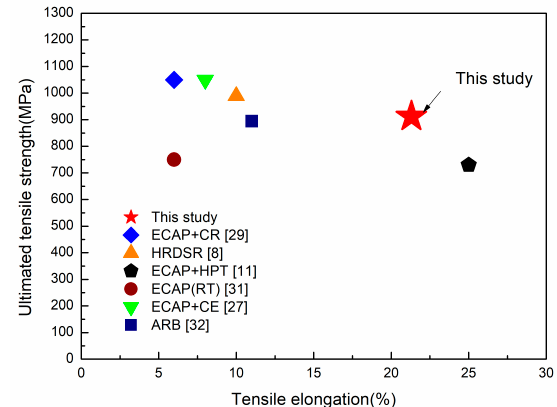
Figure 9. Comparison of mechanical properties of CP-Ti processed by different technologies in